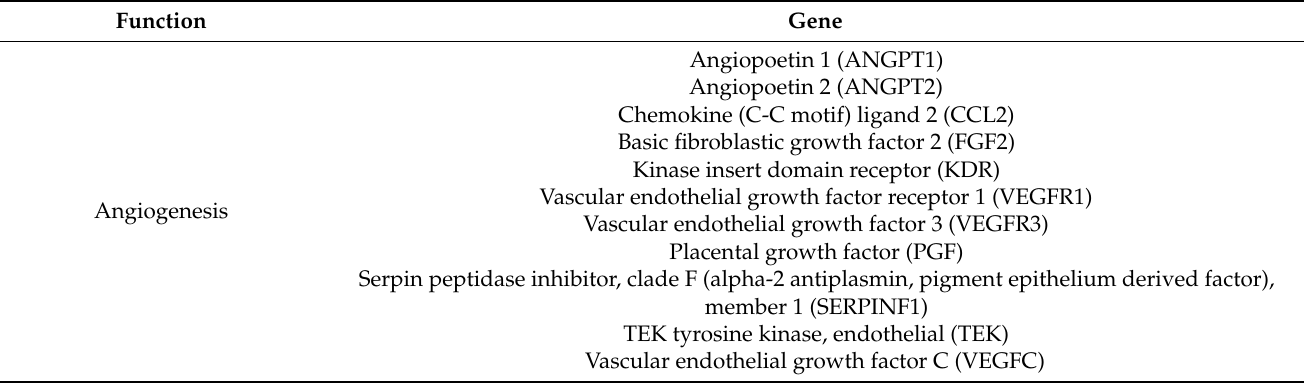
Table 1. Overview of the genes examined and their associated pathways using the Human Cancer PathwayFinder RT 2 Profiler PCR Array (Qiagen, Venlo, Netherlands). Overall, 84 genes